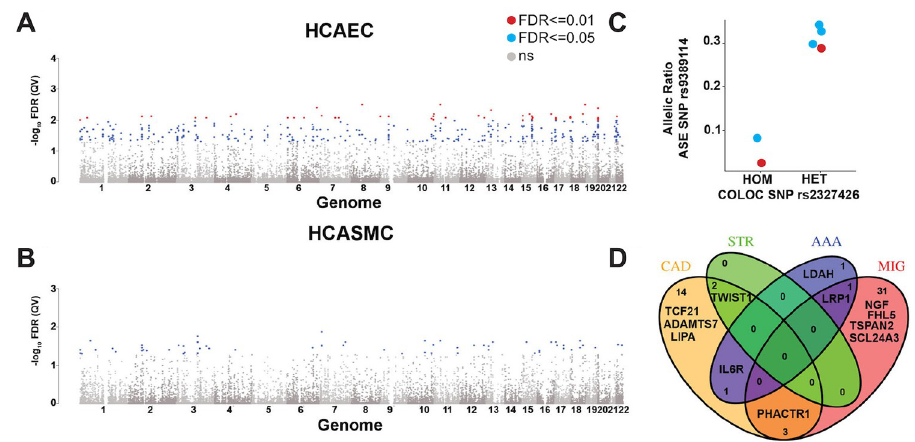
Fig 2. Non-coding variation modulating expression in vascular cells and tissues. A) and B) Manhattan plot of Allele-Specific Expression loci in HCAECs (A) and HCASMCs (B). Genomic coordinates (hg19) are plotted on the x- axis, Benjamini-Hochberg adjusted p-values (FDR) for each interrogated variant are plotted on the y-axis. SNPs with FDR � 0.05 are shown in blue and those with FDR � 0.01 in red. C) Allele-Specific Expression of TCF21 based on colocalization genotype. Allelic expression ratio (A / (A+R) = 0.5) of TCF21 at rs9389114 on the y-axis is associated with genotype of the lead colocalization variant rs2327426 on the y-axis. HCAECs are shown in red and HCASMCs in blue. D) Venn diagram of colocalization genes for 4 vascular traits. Coronary Artery Disease (CAD), Stroke (STR), Abdominal Aortic Aneurysm (AAA) and Migraine (MIG). Numbers in sectors represent the numbers of colocalization genes per group. HGNC gene names of key association genes are plotted as